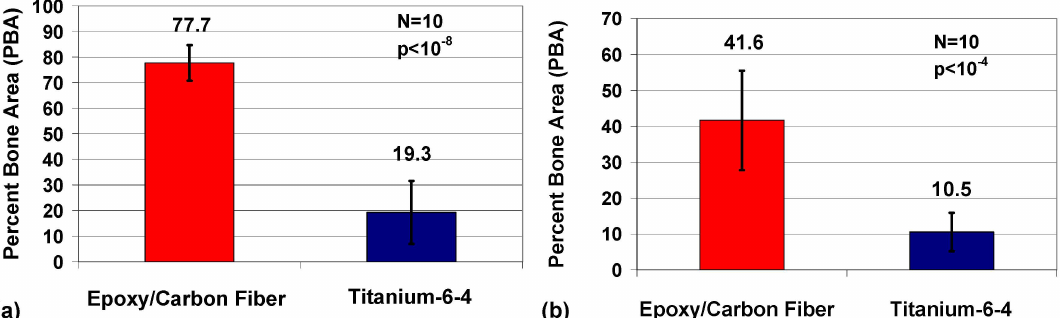
Figure 1. Implant PBAs comparing epoxy/carbon-fiber-reinforced composite to Ti-6Al-4V alloy ( a ) Distance 0.1 mm from implant; ( b ) Distance 0.8 mm from